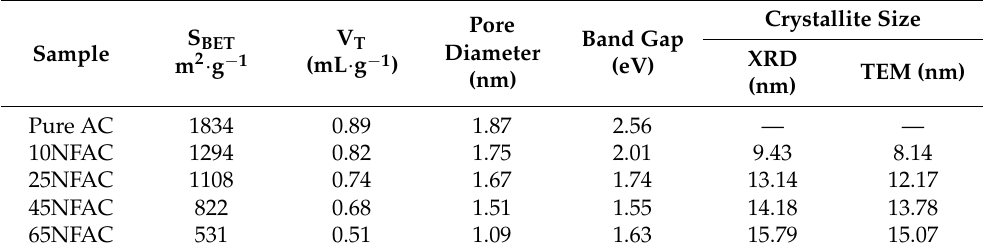
Table 1. Textural properties and crystallite size of pure and modified